Question: Provide a one-line summary of what is displayed.
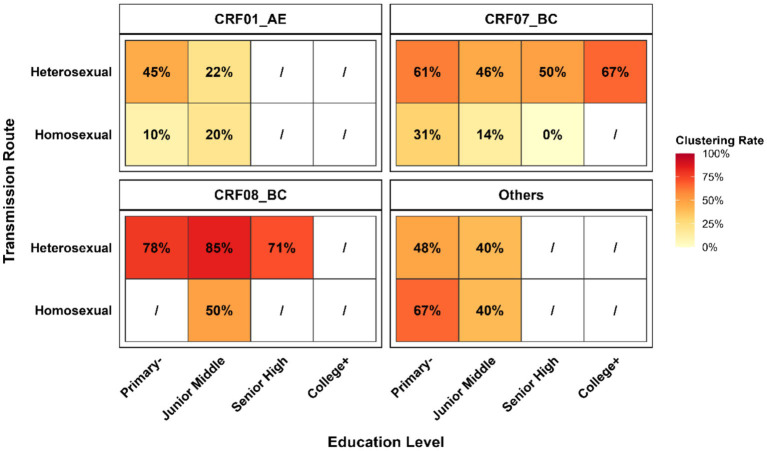
Answer: Heatmap of HIV-1 clustering rates stratified by subtype, transmission route, and education level.